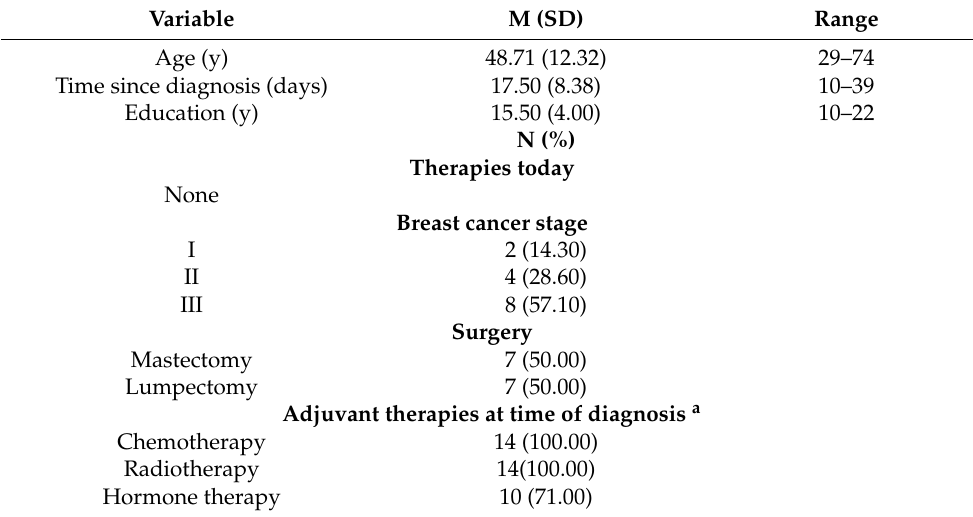
Table 1. Participants’ personal and breast cancer characteristics (N =